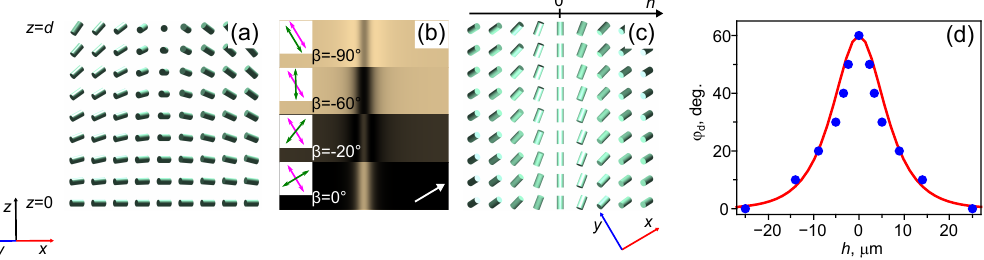
Figure 4. The calculated director configuration of a nematic in the cross-section of the layer near the domain wall ( a ); The image of segment of domain wall for different β angles between analyzer and rubbing direction obtained by the FDTD method ( b ); The director orientation near the domain wall on the substrate covered with PiBMA film ( c ); The theoretically calculated (solid line) and experimentally measured (points) dependences of the azimuthal angle of director rotation ϕ d on the distance h from the center of the domain wall ( d ). The LC layer thickness is d = 21 µ